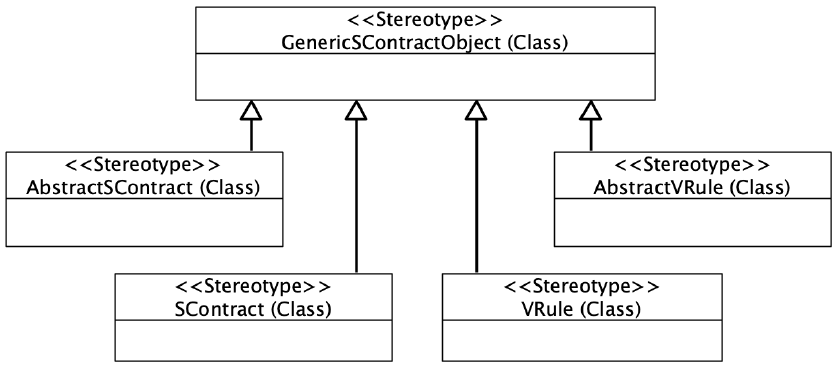
Figure 3. The UML profile diagram with platform-independent